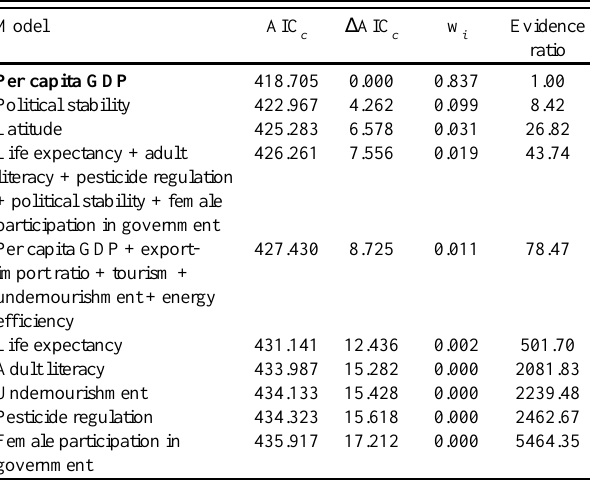
Table 7 . A comparison of support for the top 10 models of Fig. 5 . The model best explaining the proportion of social-ecological factors and the proportion of invasive endangered and invasive birds and mammals combined was mammals in 100 different countries. Models were ranked by the human life expectancy in a country. A higher proportion Akaike’s (AIC), and parameter of endangered and invasive birds and mammals equates to a abbreviations are as follows: D AIC is the difference between lower resilience. The proportion of endangered and invasive c AIC values from each model, and w is the Akaike weight. birds and mammals combined ranged from 1.21% to c i Bold values indicate variables in the best model. 41.82%, and life expectancy ranged from 38.6 years to 82.1 years. New Zealand is an extreme outlier.